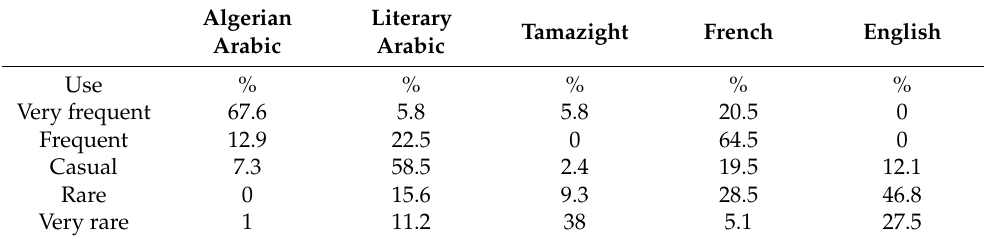
Table 1. Daily linguistic practices in a survey of 50 students (age